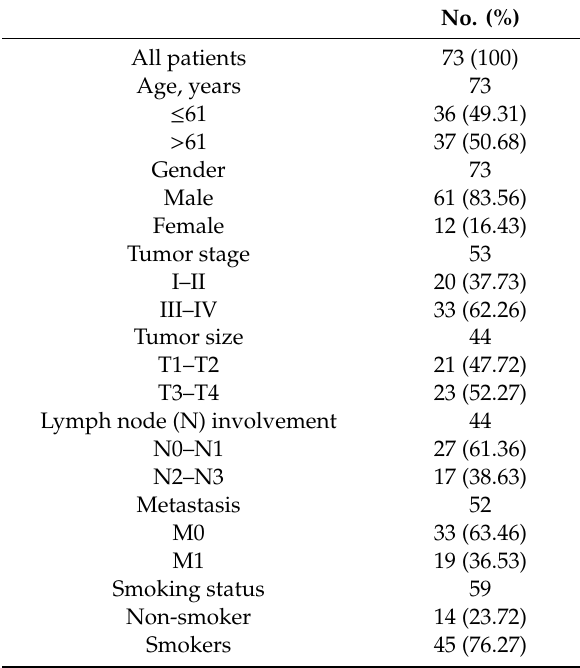
Figure 1. Flow chart of the analytical methods used. Table 1. Clinical pathological characteristics of patients ( n = 73).